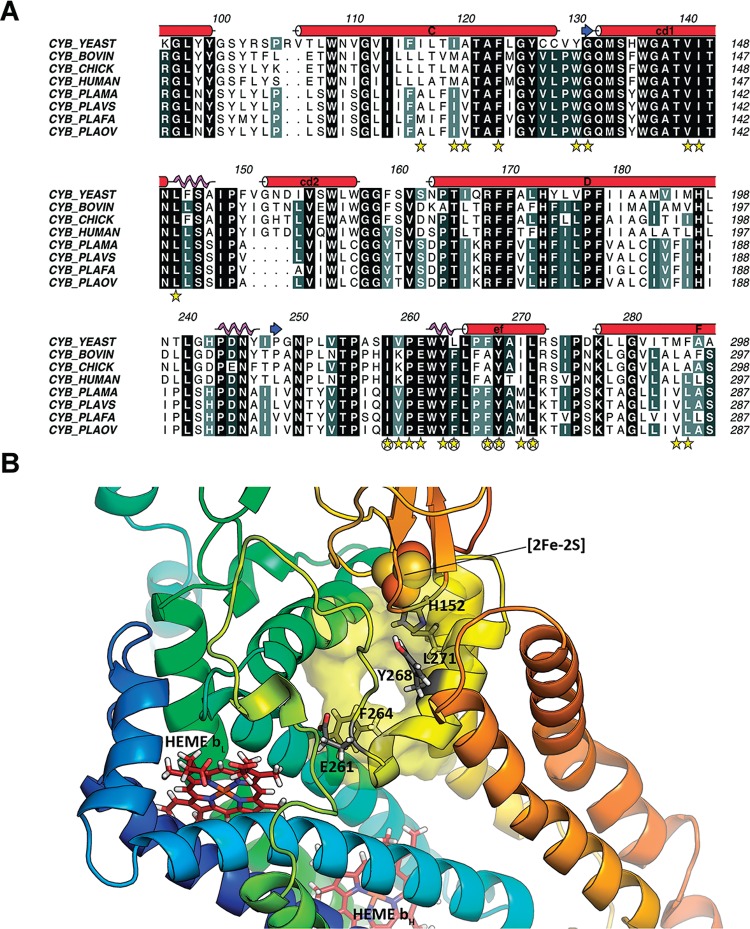
: characterisation of Qo site in Plasmodium falciparum bc1. (A) Alignment of cytochrome b sequences from Plasmodium sp causing human malaria and homologous proteins in yeast, cow, chicken and human showing structural elements composing the Qo site. Yellow stars mark residues predicted to be involved in atovaquone binding. Circumscribed stars mark residues associated with atovaquone resistance. Alignment was prepared with help of the program Aline v1.0 (Bond & Schuttelkopf 2009); (B) Zoomed view of the Qo site showing in sticks residues involved in atovaquone binding and/or resistance development.